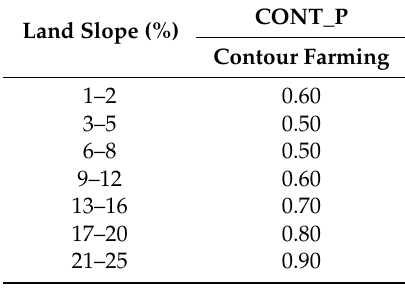
Table 2. USLE practice factor (CONT_P) for contour